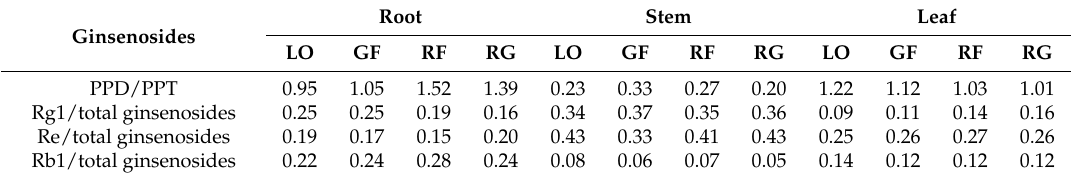
Table 1. The ginsenoside compositions of the root, stem, and leaf during different growth times. Root Ginsenosides